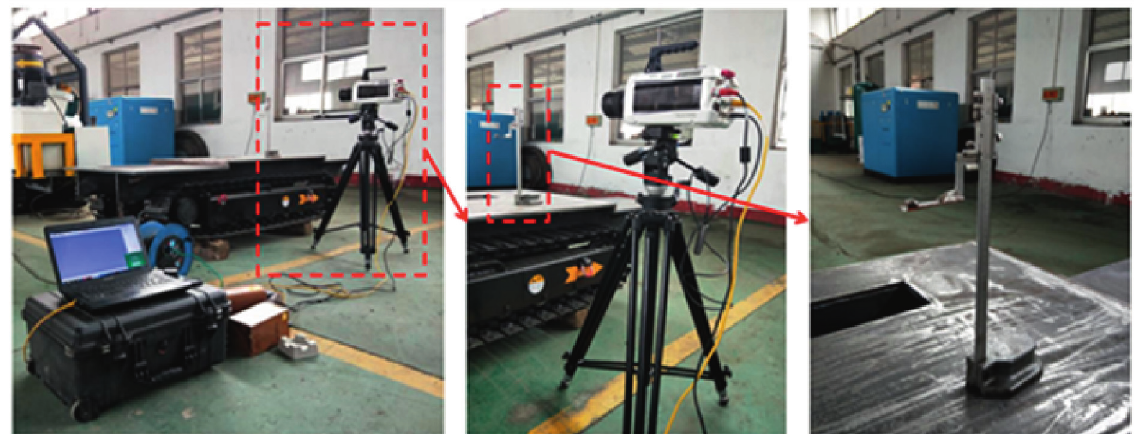
Figure 8: Experimental apparatus for determination of coefficient of restitution.